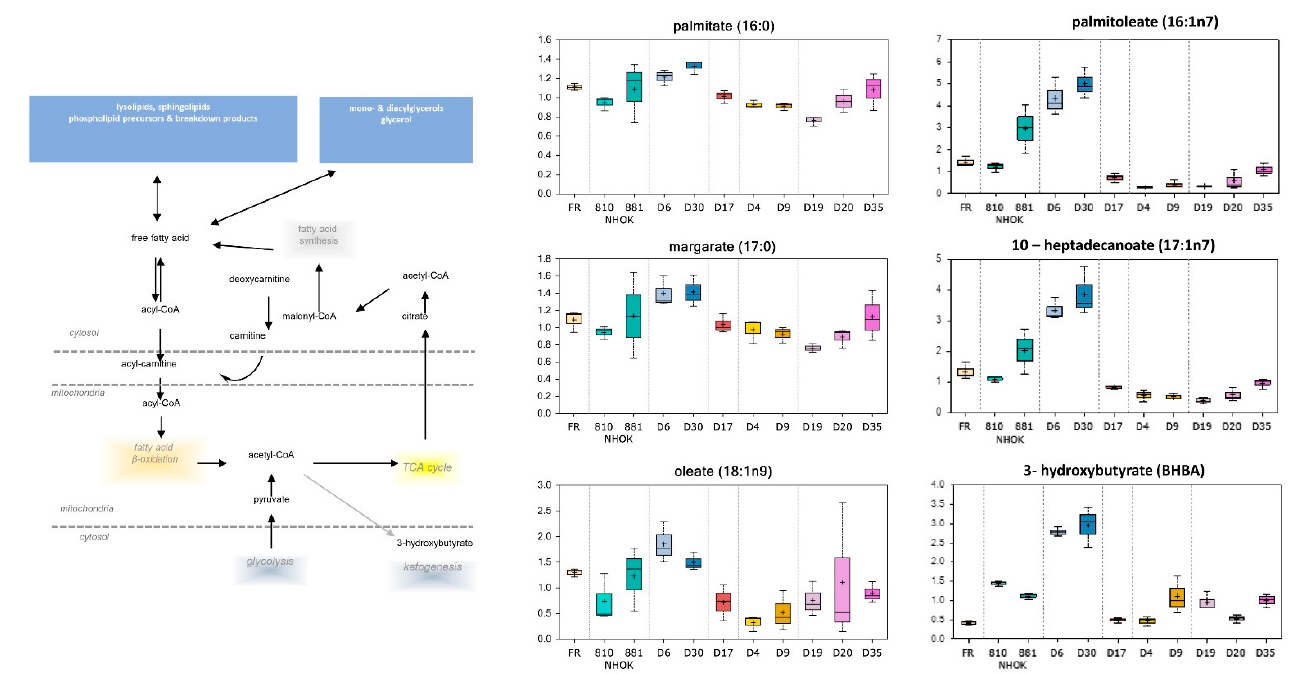
Figure 4. Alterations of lipid metabolism in PPOL and normal keratinocytes. The symbols are the same as for Figure 3. Data represents the means of three independent experiments +/ − standard deviation. For statistical analyses see Supplementary Tables S3–S7. TCA = tricarboxylic acid cycle.